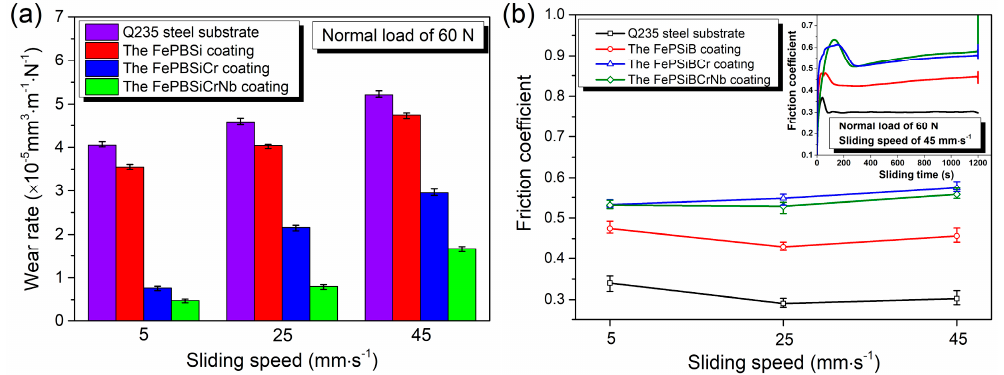
Figure 3. ( a ) Wear rates and ( b ) friction coefficients of the samples with various sliding speeds ( P = 60 N).